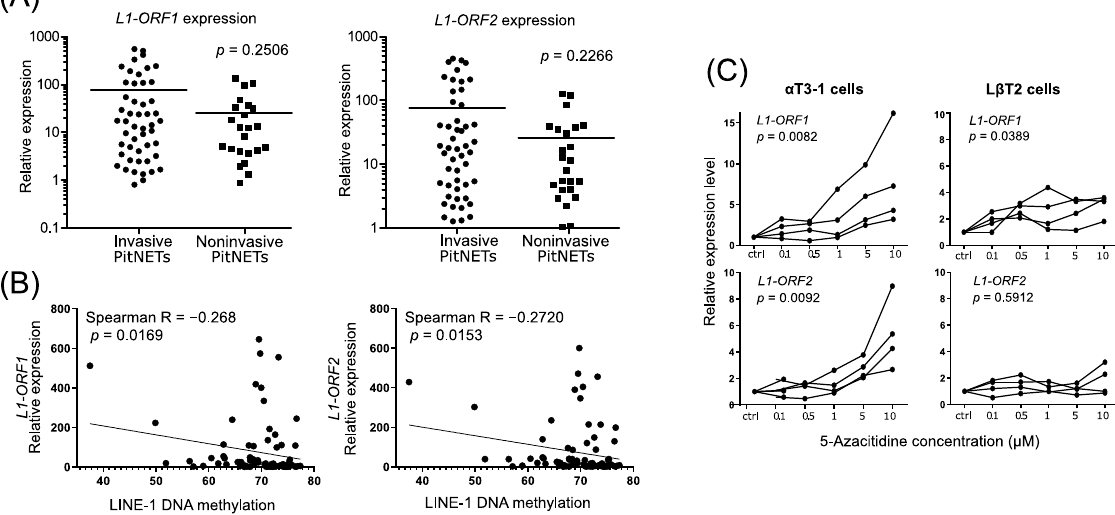
Figure 2. Expression of L1-ORF1 and L1 - ORF2 transcripts. ( A ) Comparison of LINE-1 mRNA L1-ORF1 and L1-ORF2 levels in invasive ( n = 54) and noninvasive ( n = 26) nonfunctioning gonadotroph PitNETs. Each dot represents particular tumor sample, horizontal line indicates mean value; ( B ) Correlation analysis of LINE-1 DNA methylation end expression levels of L1-ORF1 and L1 - ORF2. ( C ) The expression of L1-ORF1 and L1 - ORF2 in gonadotroph cell lines upon treatment with 5-AzaC. The results were normalized to control cells (CTRL). The lines connecting datapoints represent independent